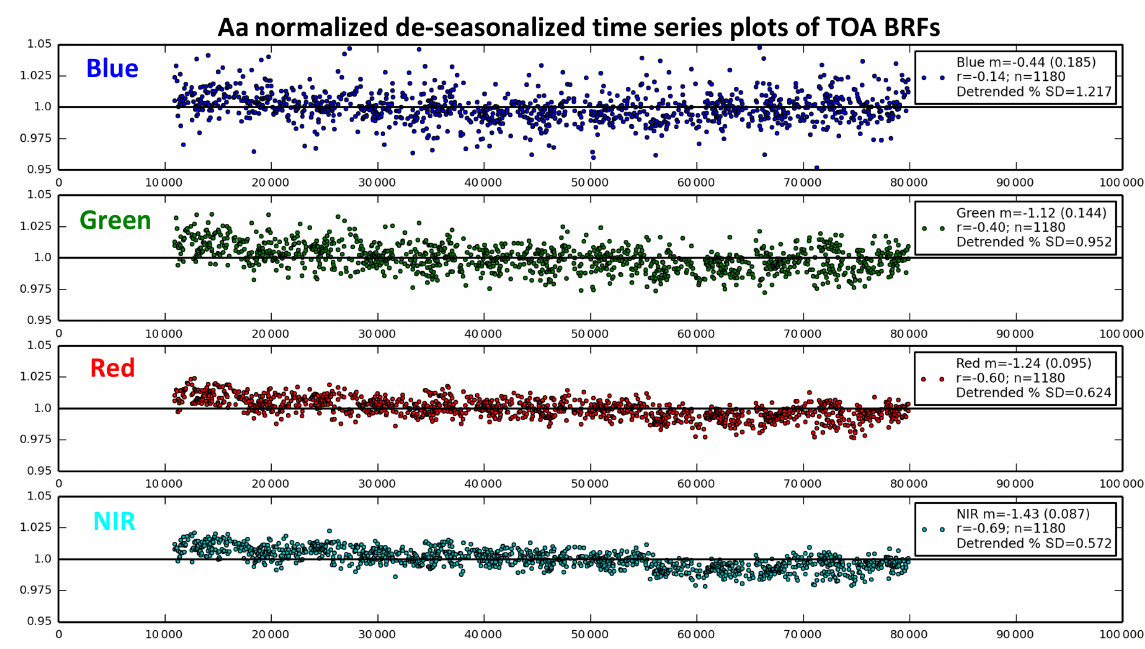
Figure A2. Normalized, de-seasonalized TOA BRF time series plots, for the four spectral bands of the MISR Aa camera. Data are normalized such that the mean value is unity. These data present all of the data for the three desert sites used (Libya-1, Libya-4, and Egypt-1), excluding outliers, processed through Step 4b of Appendix